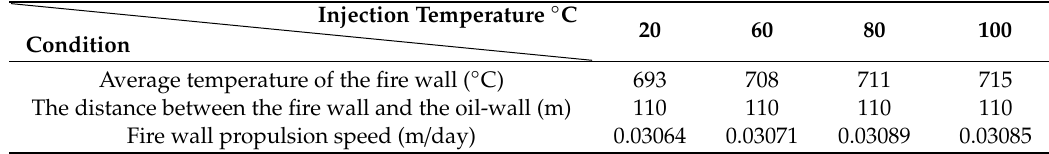
Table 10. Characteristic parameters of the fire wall under di ff erent air injection temperatures.